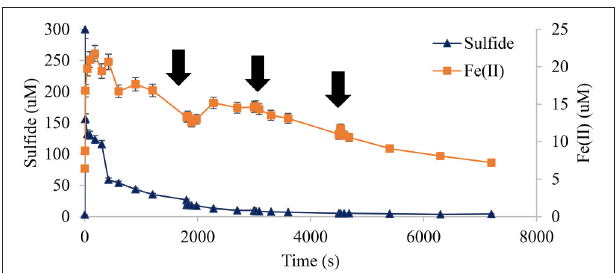
FIGURE 11 | Contrasting sequential additions of hydrogen peroxide had no statistically significant effect on Fe(II) or HS − . Therefore, hydrogen peroxide was not a source of feedback or reductive equivalents that affected Fe(II) or the rate of HS − oxidation ( indicates time of peroxide addition pH, 8.25, 1.00 wt% marsh mud shown, each addition sufficient for a net 10 × 10 − 6 M increase in peroxide).